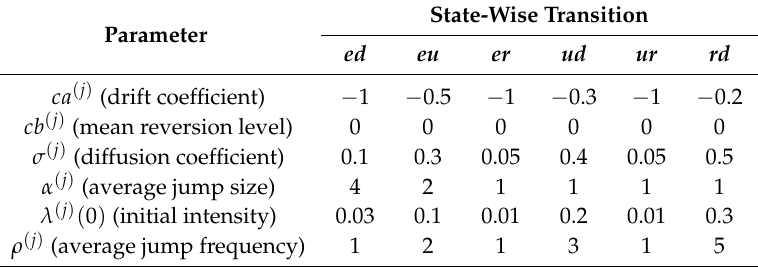
Table 1. Parameter values for the jump-diffusion process used in the Markov chain of Figure 2. State-Wise Transition Parameter ed eu er ud ur rd ca ( j ) (drift coefficient) − 1 − 0.5 − 1 − 0.3 − 1 − 0.2 cb ( j ) (mean reversion level) 0 0